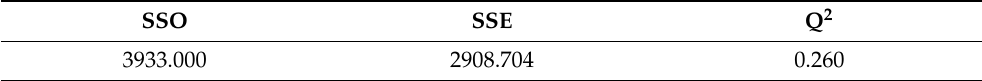
Table 10. Predictive relevance analysis of model.